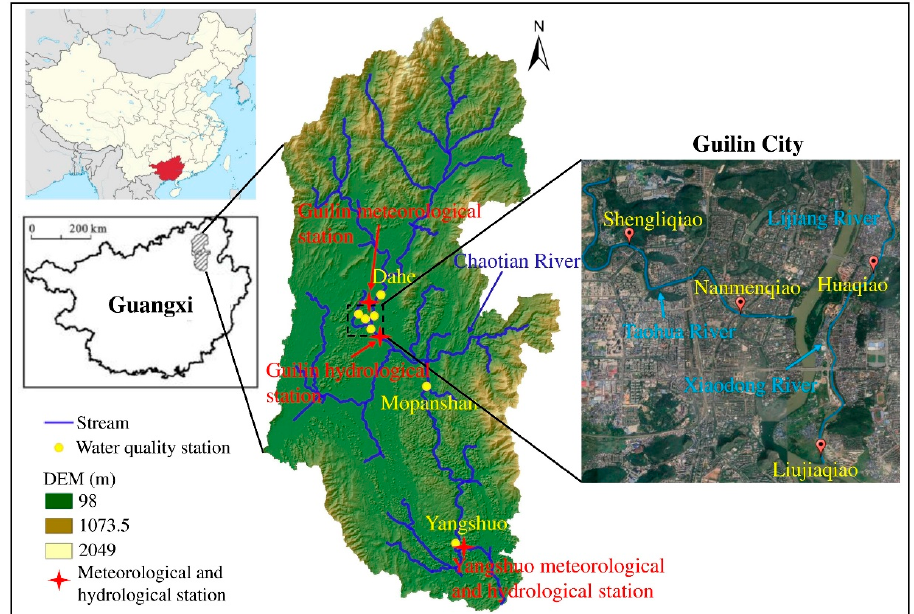
Figure 1. Study area and distribution of meteorological, hydrological, and water environmental stations.